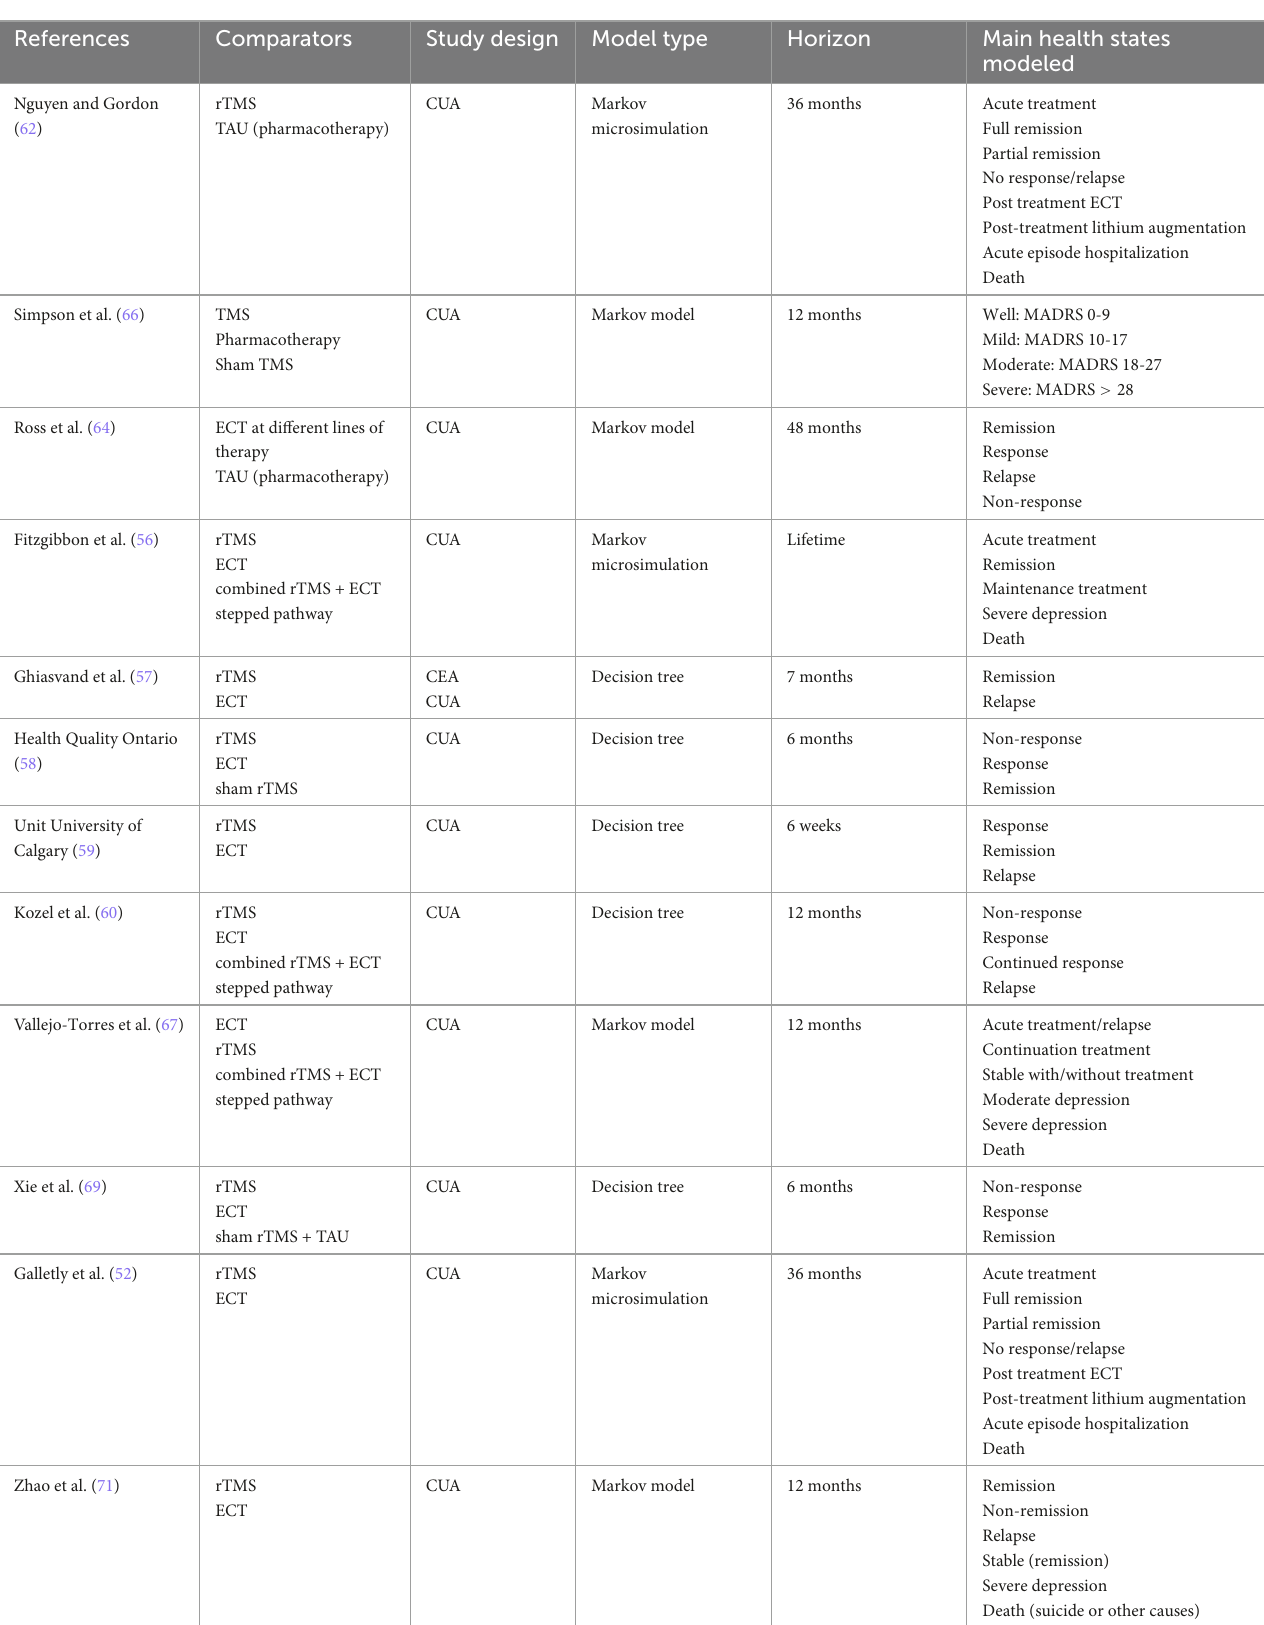
TABLE 3A Model characteristics for economic evaluations of non-pharmacological